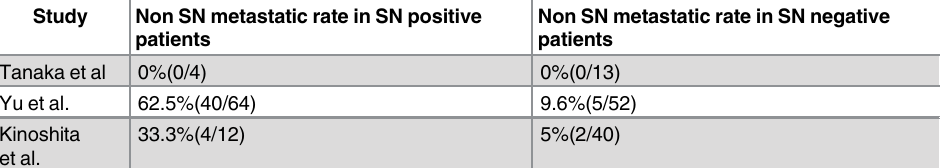
Table 6. The metastatic rate to non-SNs according to SN status in initially clinically node-negative breast cancer patients after